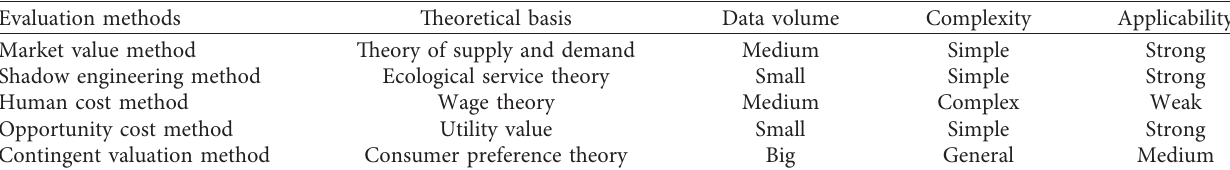
Table 2: Comparison of quantitative evaluation methods of the negative externality.